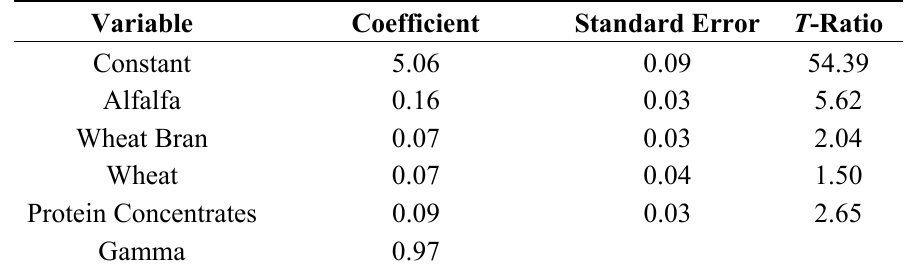
Table 5. Goat maximum likelihood estimates: stochastic frontier production frontier.